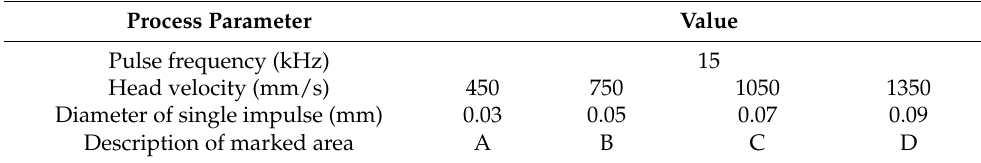
Table 3. The laser beam parameters for specific graphic fields used during the laser marking process of the actual research